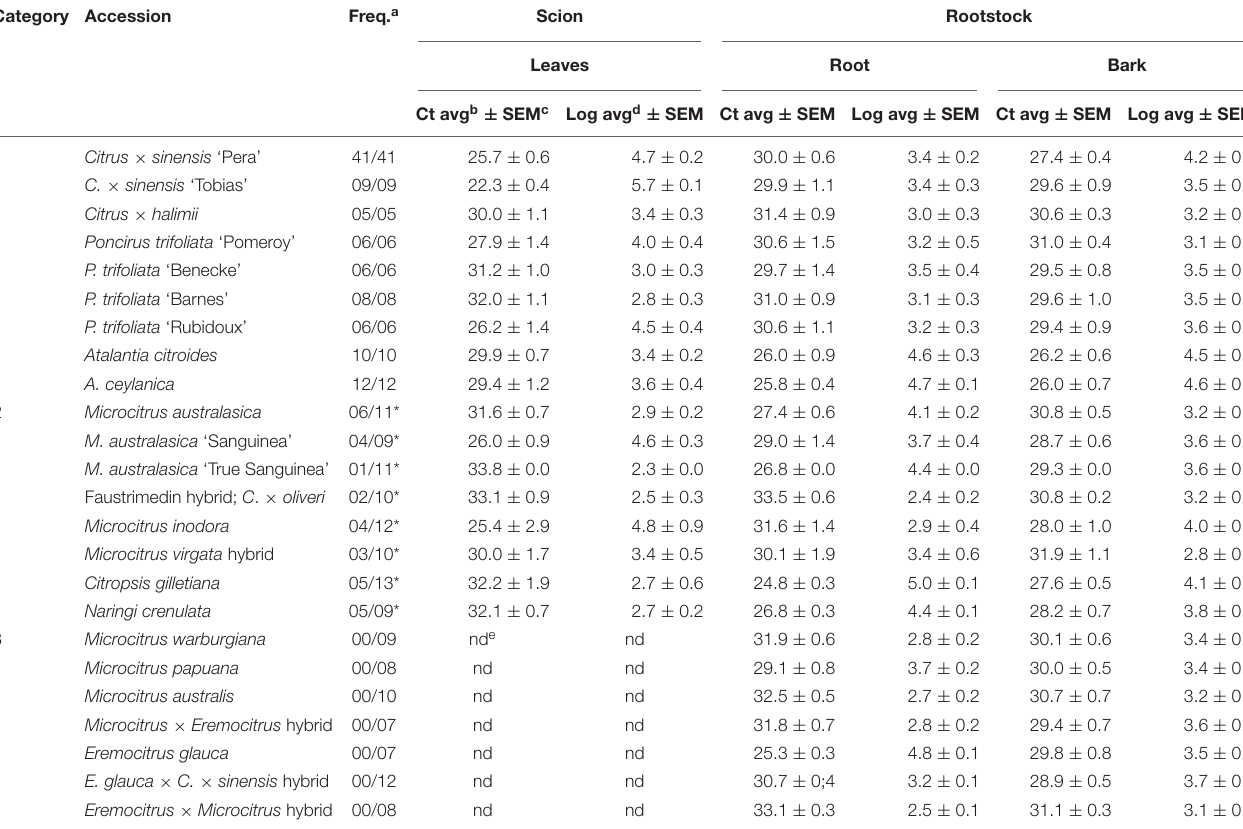
TABLE 2 | ‘ Candidatus Liberibacter asiaticus’ infection in the Citrinae genotypes evaluated as determined through detection of the 16S DNA by qPCR at 12 months after infection. Category